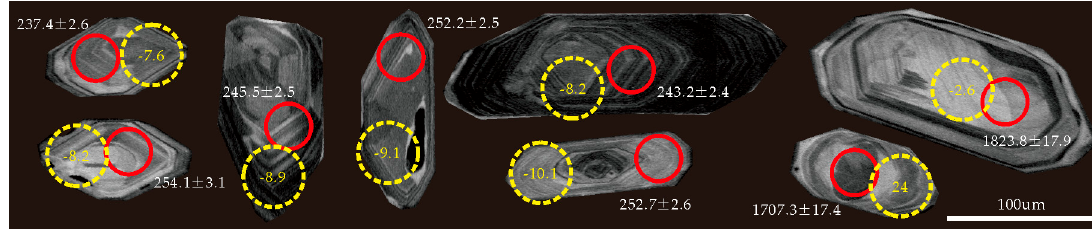
Figure 5. Representative CL images of zircons separated from diorite sample 17ZRD01 with identified analytical spot, U–Pb age (Ma) and ε Hf (t) value. Red circle: U–Pb beam. Yellow dash circle: Lu–Hf beam.